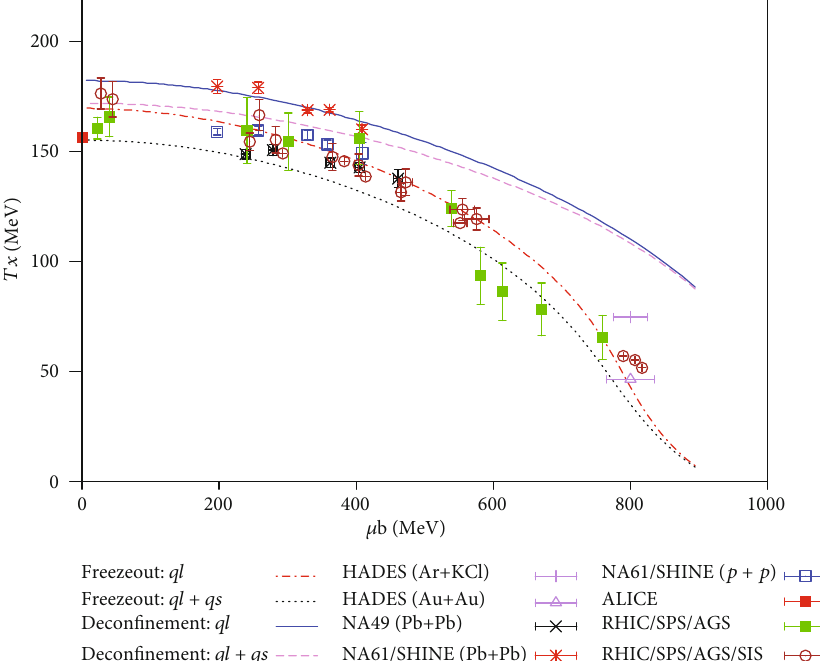
ff erent experimental results (symbols with error bars) Figure 1: The freezeout and decon fi nement parameters T χ and µ b as deduced from di are depicted and confronted with the thermal model calculations for the chemical freezeout (dot-dashed and dashed curves) and decon fi nement parameters (solid and long-dashed curves) with and without strange